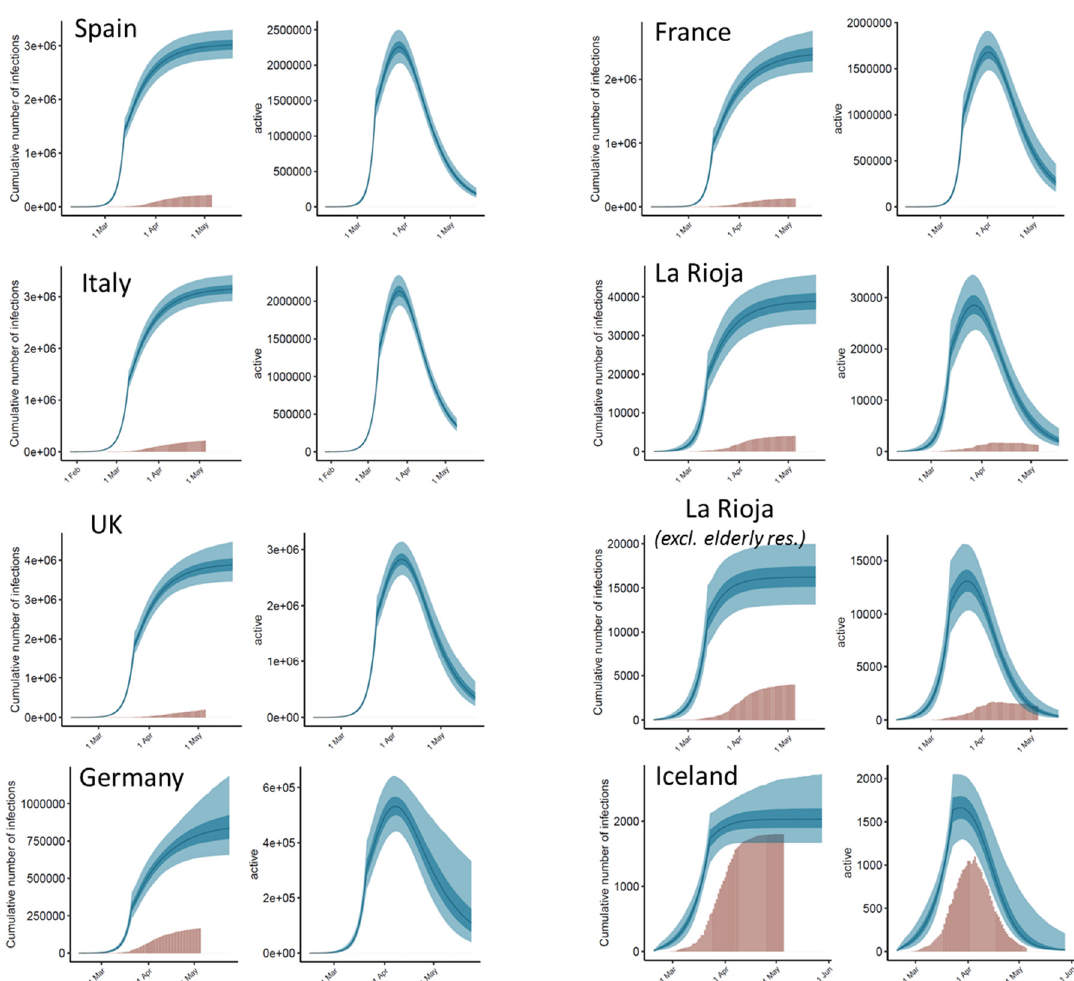
Figure 4. Estimated cumulative infections and active cases from an independent application of the model to each country and region. For each country, the left plot shows the estimated cumulative infections for each day as compared with the reported ones, and the right plot shows the expected active cases for each day (in some countries, they are compared with the reported ones). Expected values are shown as blue bands: light blue (95% CI), dark blue (50% CI) and line (median). Observed values are shown as brown bars. The estimates of R t before and after intervention resulting from the model are the ones in Table 3. In all cases, after intervention, R t is significantly reduced to a value well below 1 and the number of new infections decreases. In the La Rioja second panel, estimates are derived from observed deaths after excluding those from elderly retirement homes, but accumulated infections and active cases over time are the total ones, since the daily cases excluding elderly retirement homes was not available for this work. Table 4. Estimated cumulative infections as of 5 May 2020 (shown median values with 95% credible interval). Country/Region